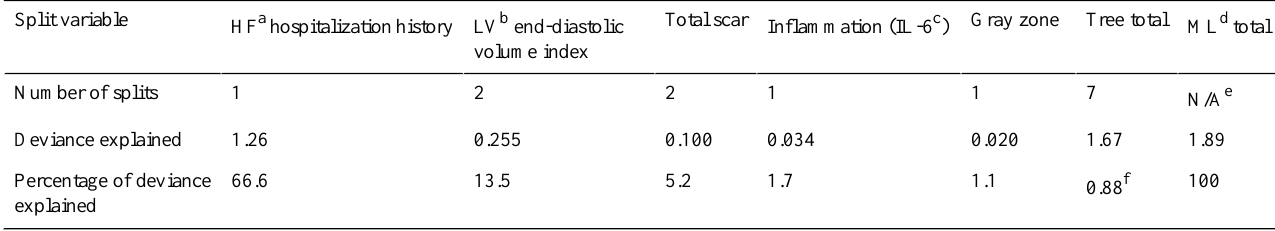
Table 2. This table summarizes the global summary tree (shown in Figure 3) with an analysis of the variation (deviance) in the predicted values (P) from the machine learning (ML) model explained by the predictors in the global summary tree. The number of splits contributed by each variable in the global summary tree is enumerated along with the deviance and the percentage of the deviance explained. The predictors' ranked importance (ordered from most to least important from left to right in the table) is determined from the percentage of the deviance